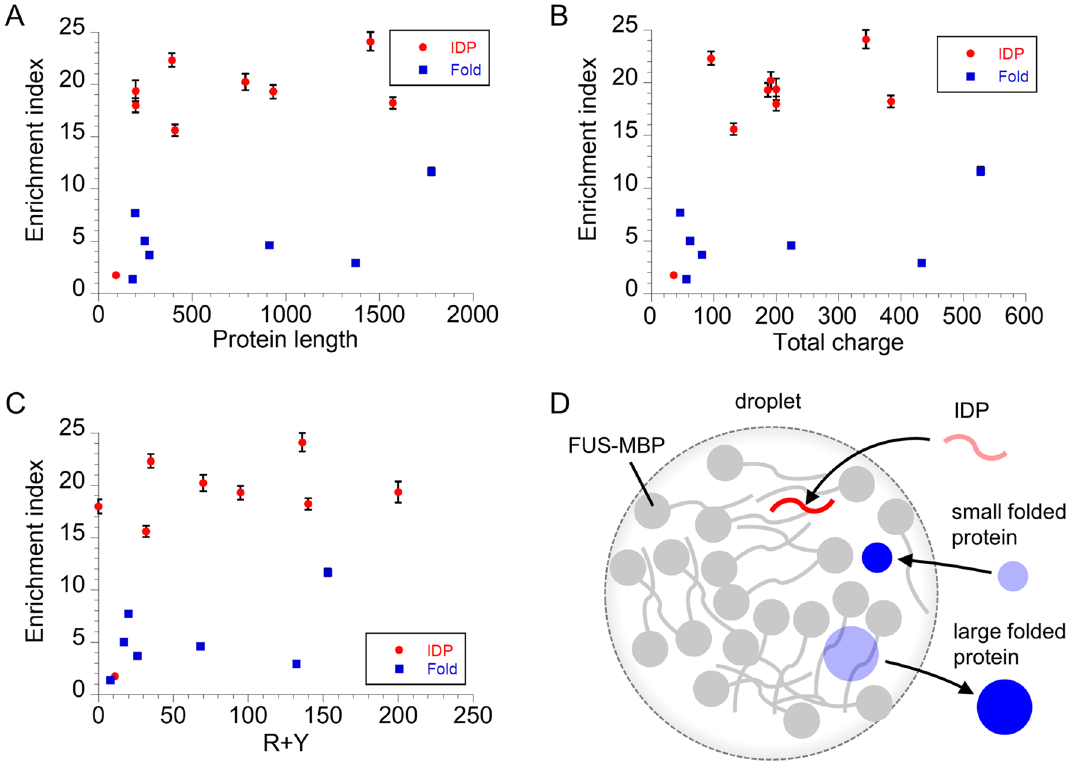
Figure 2. Enrichment index of guests in FUS droplets depends on the structural type, rather than intermolecular interaction. ( A ) Protein length dependence of enrichment index (EI) of guest proteins. ( B ) Total charge dependence of EI of guest proteins. ( C ) EI of guest proteins against a function of R plus Y number. In panels ( A – C ), errors denote the standard errors. ( D ) Proposed model of structure-dependent recruitment in a FUS droplet. The droplet (dashed grey circle) is formed by host FUS-MBP (grey). IDP (red) and small folded protein (small blue circle) are recruited into the droplet void, whereas large folded protein (large blue circle) is excluded from the relatively small void of the (Fig. 3B). The average diffusion coefficient ( D ), obtained by fitting the MSD plots to a linear equation with a 4 D slope, was 0.074 μm 2 /s.